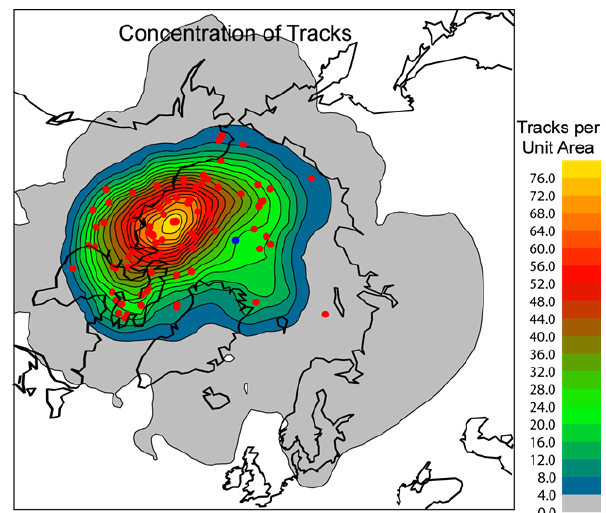
Fig. 10. Spatial concentration of tracks for the study period. The unit area used is a spherical cap with a 5 ◦ arc angle. Results are for the whole 12-month study period. Red markers indicate the loca- tions where maxima are first detected by TRACK. The blue marker indicates the position of the geomagnetic pole. Note the bias toward North America in these